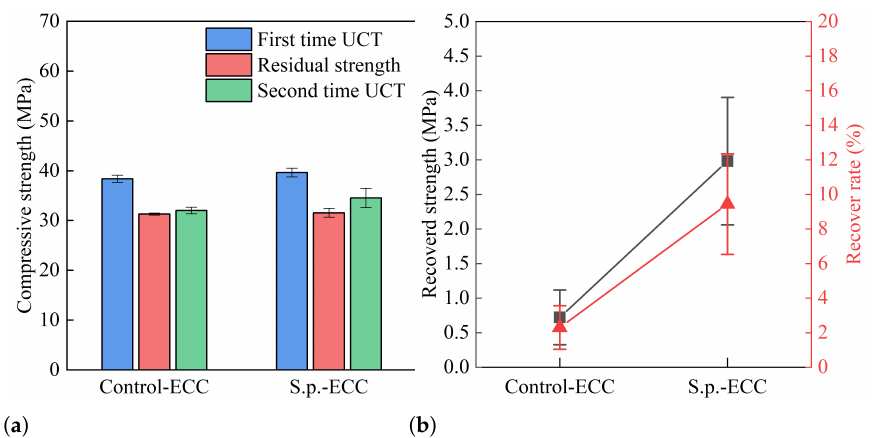
Figure 8. Strength recovery of ECC samples at early age (7 days). ( a ) Compressive strength for repeated compression tests. ( b ) Strength recover rate.